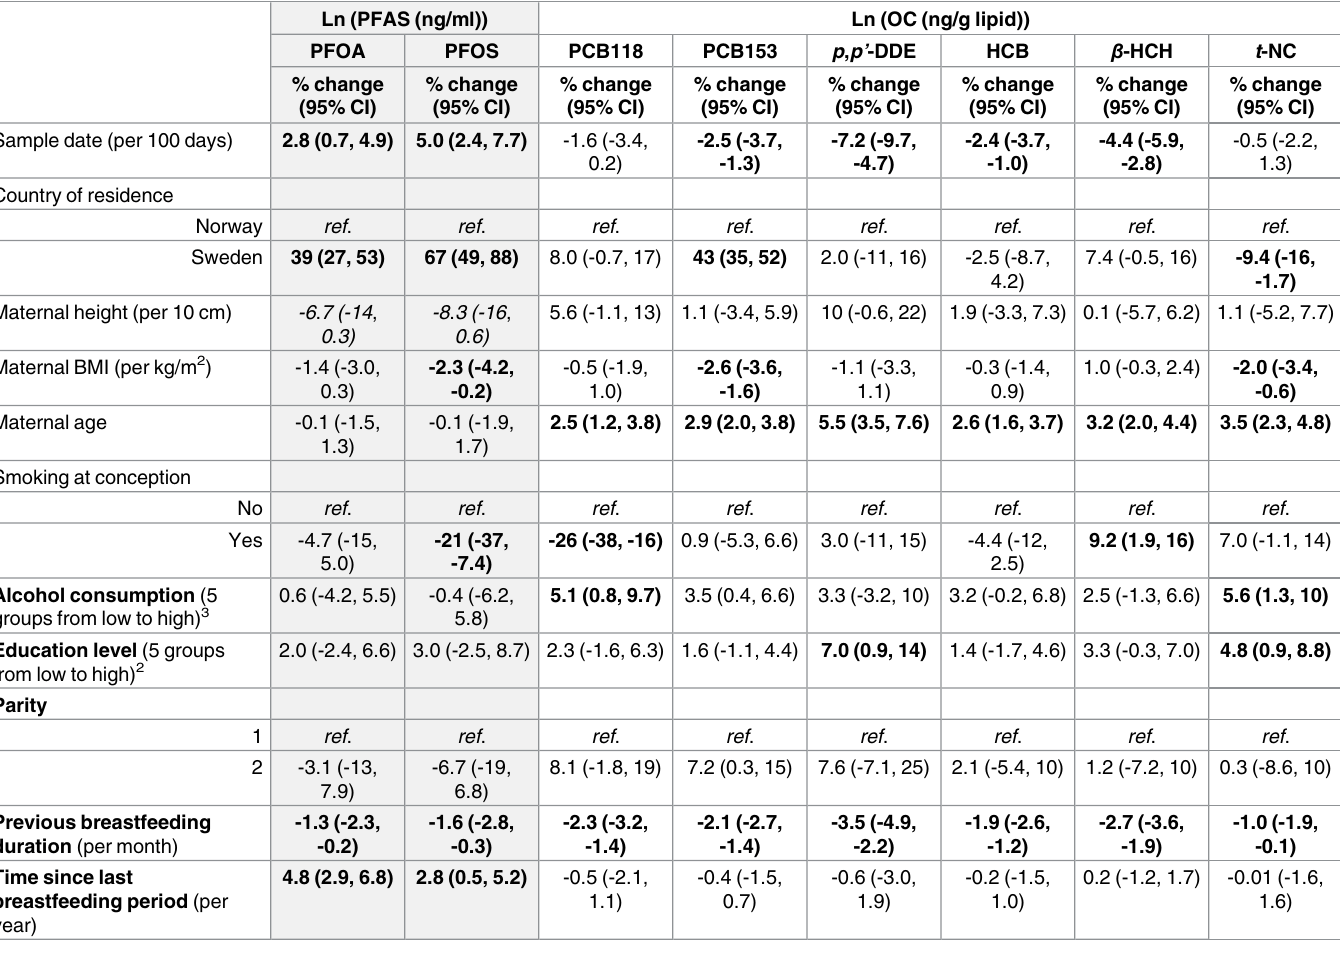
Table 3. Adjusted 1 associations from multivariable linear regression models for sociodemographic and pregnancy-related variables and ln- transformed maternal PFAS (ng/ml) and OC levels (ng/g lipids) in serum collected in 2nd trimester(n =